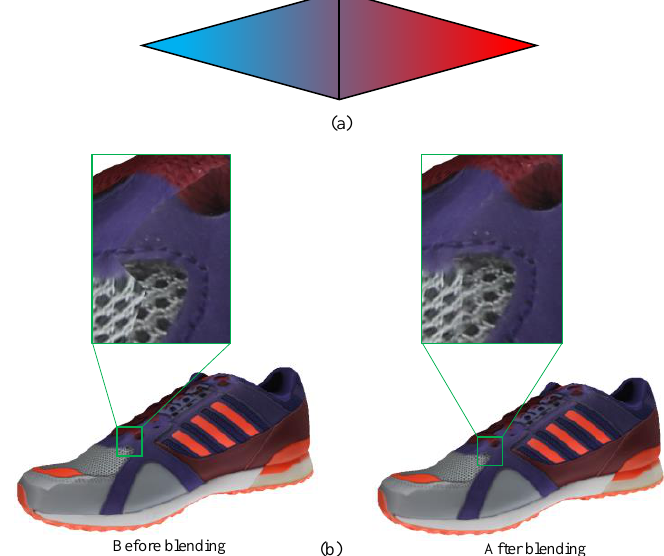
Figure 9. Texture blending at the transition of different images: ( a ) the blending of two neighboring meshes, and ( b ) a shoe example before and after blending.